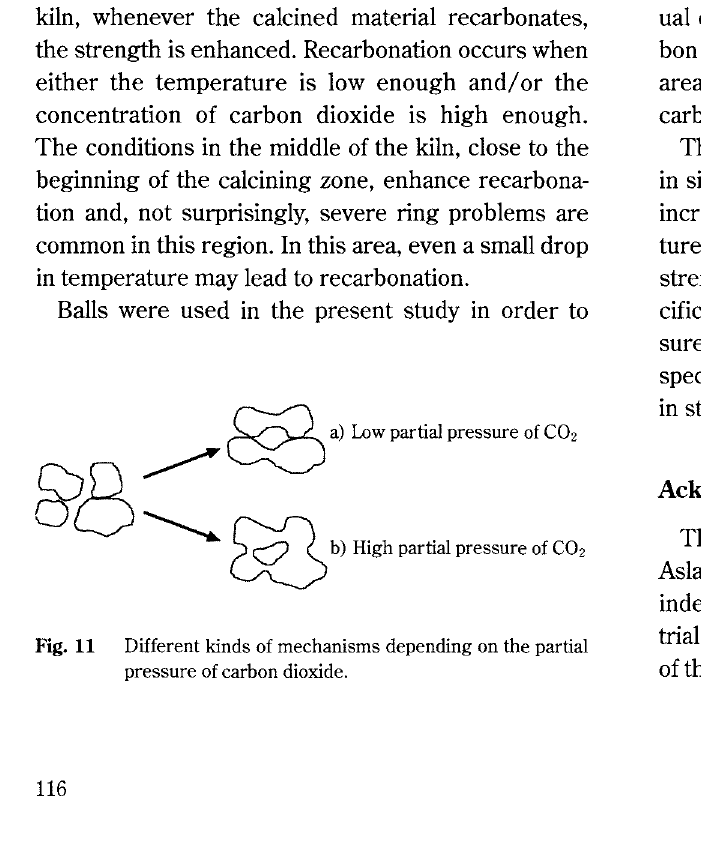
Different kinds of mechanisms depending on the partial pressure of carbon